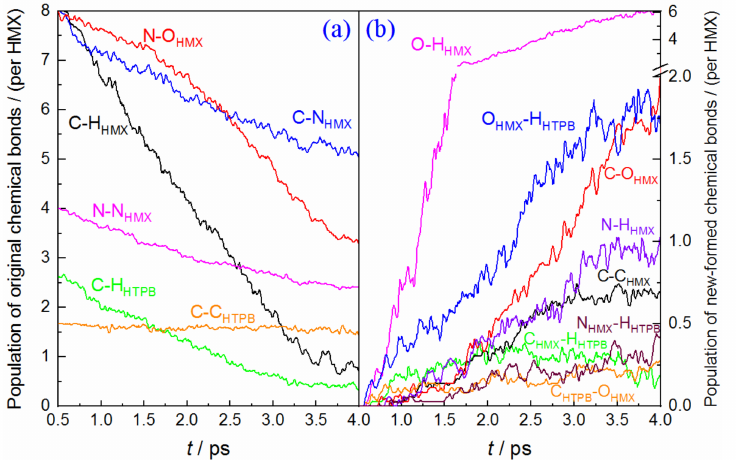
Figure 6. Time dependence of the main chemical bonds involved in HMX(001)/HTPB shock decom- position, ( a ) original chemical bonds, ( b ) new-formed